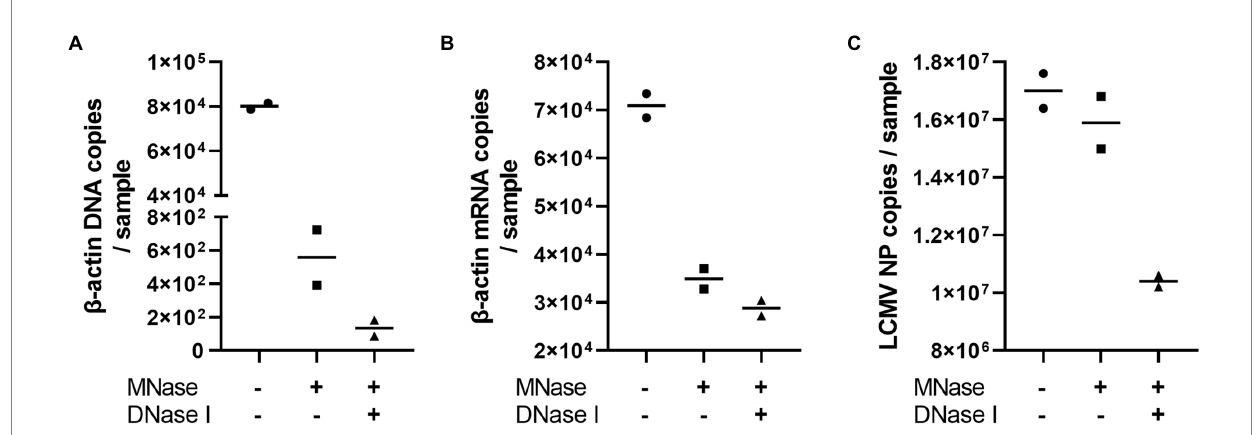
FIGURE 2 The effects of Micrococcal Nuclease and DNase I treatment. The LCMV culture supernatant was treated with DNase I for 30 min following Micrococcal Nuclease treatment for 60 min to prepare viral RNA. The residual genomic DNA, mRNA and LCMV RNA corresponding to the copy numbers of β -actin DNA (A) , β -actin mRNA (B) and LCMV NP RNA (C) in purified RNA solutions were measured after Micrococcal Nuclease (MNase) with or without DNase I (DNase I)